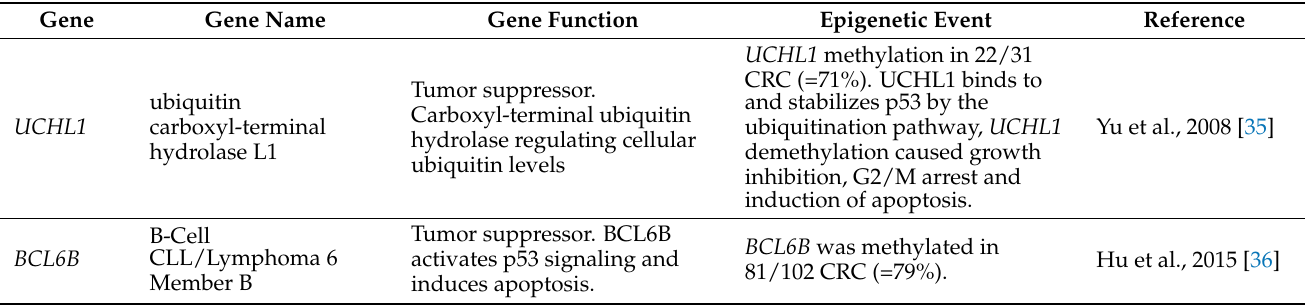
Table 1. Epigenetic alterations upstream of